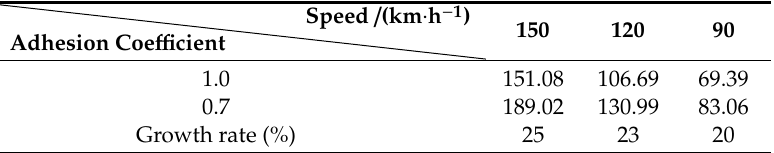
Table 1. Influence of di ff erent adhesion coe ffi cients on brake